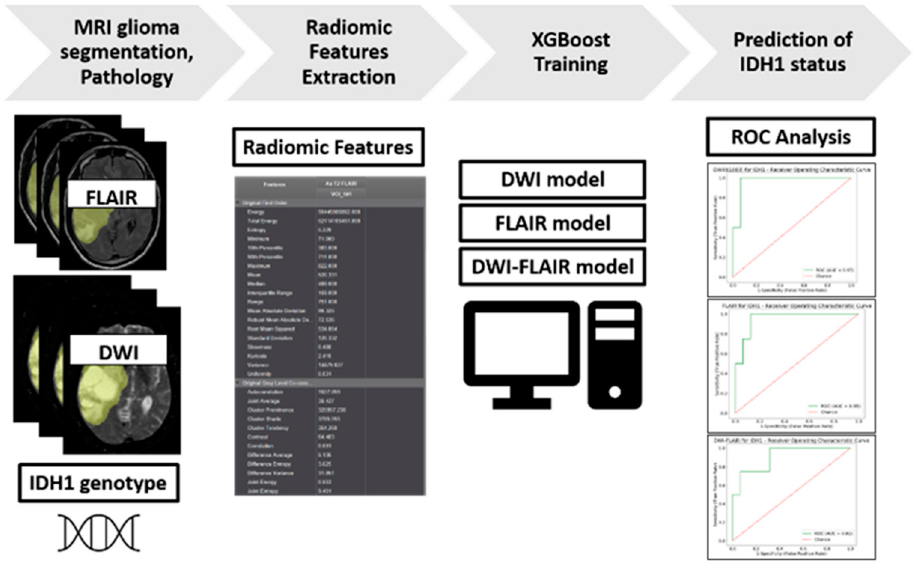
Figure 2. Study Design Diagram.